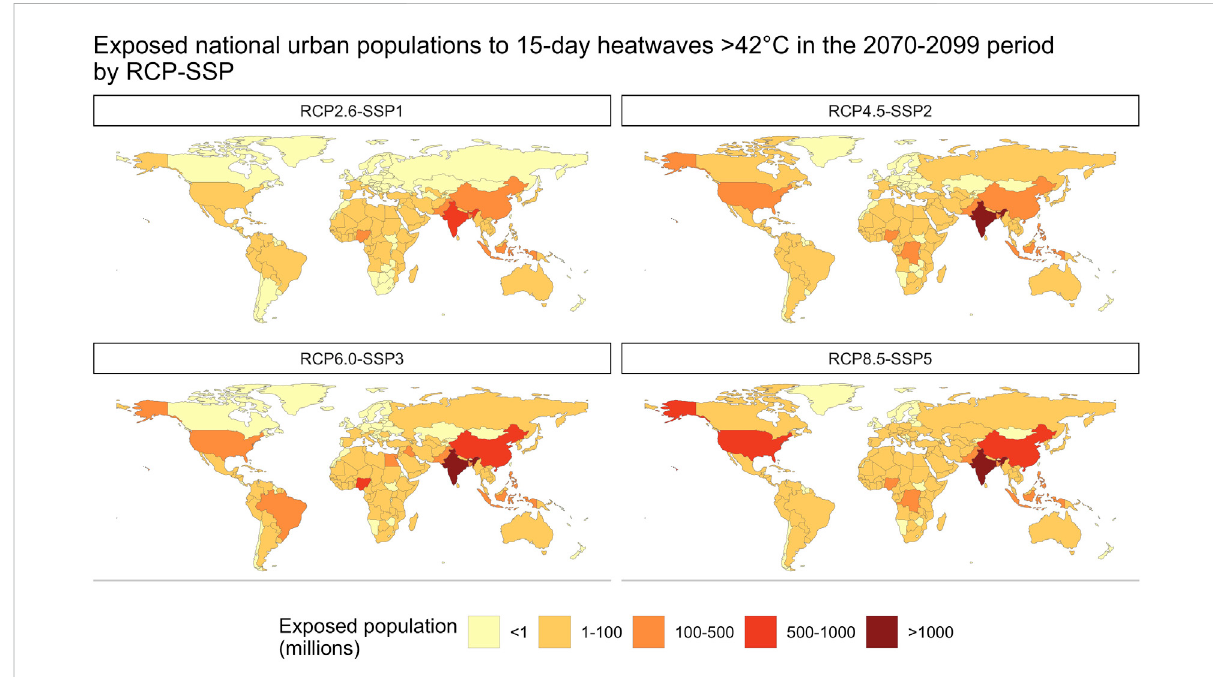
FIGURE 6 Exposed national urban populations to 15-day heatwaves > 42 ° C in the 2070 – 2099 period by RCP-SSP. This map presents the mean projected numbers of urban residents exposed to extreme 15-day heatwaves by RCP-SSP pairs in countries by the 2070 – 2099 period. The top countries that are consistently are projected to have the highest urban resident exposure to extreme heatwaves include India, China, Nigeria, Pakistan, Indonesia, Bangladesh and the Philippines, although several countries are occasionally on the list of top ten countries, including the United States, Japan, Republic of Congo, Iraq, Brazil and Egypt.